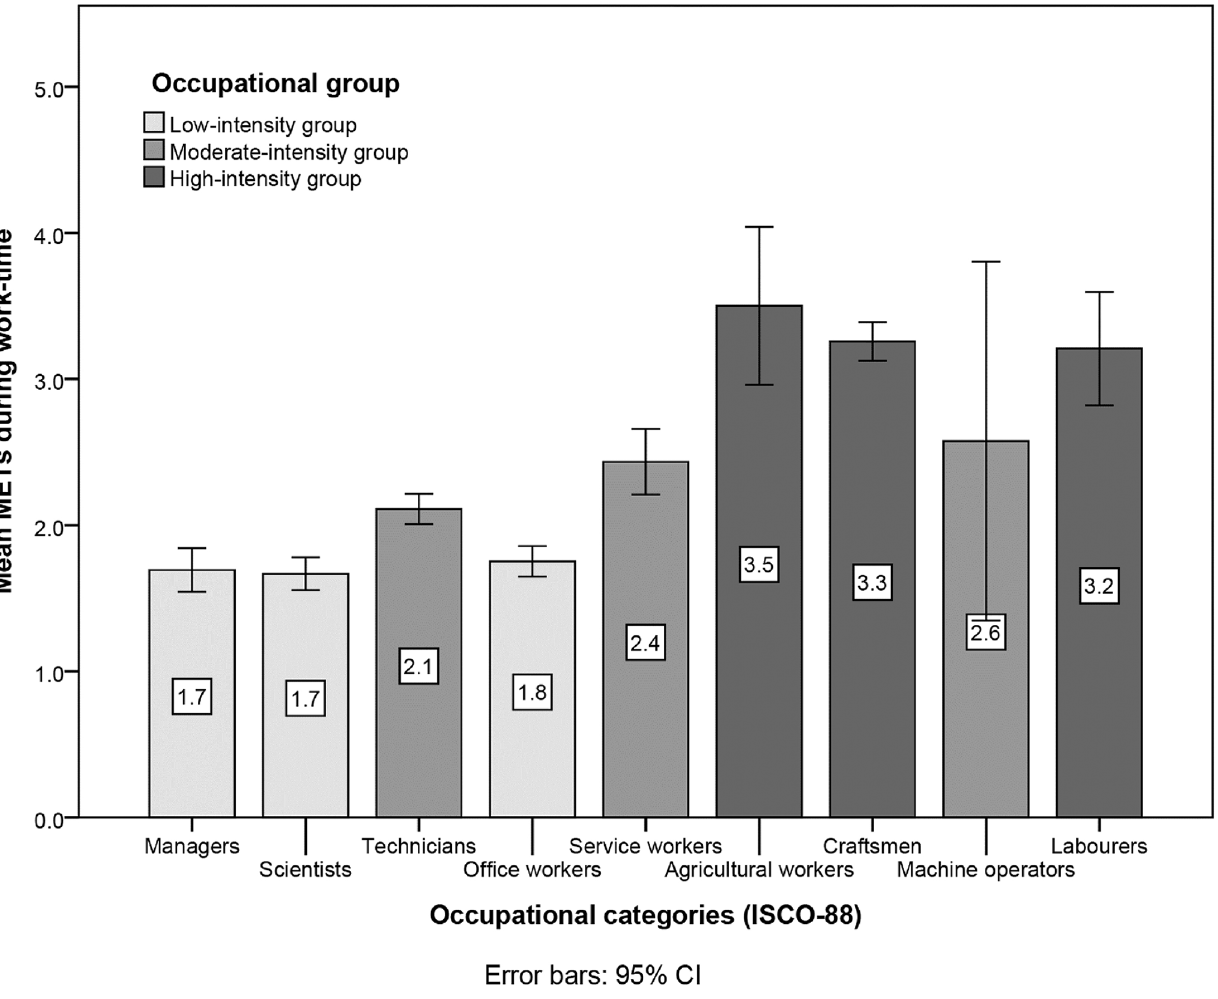
Fig 1. Differences in METs during work-time across occupational categories of the ISCO-88. CI, confidence interval; ISCO-88, International Standard Classification of Occupations 1988; METs, metabolic equivalents. Intergroup comparisons (low-intensity vs. moderate- intensity vs. high-intensity group) revealed highly significant differences (p <